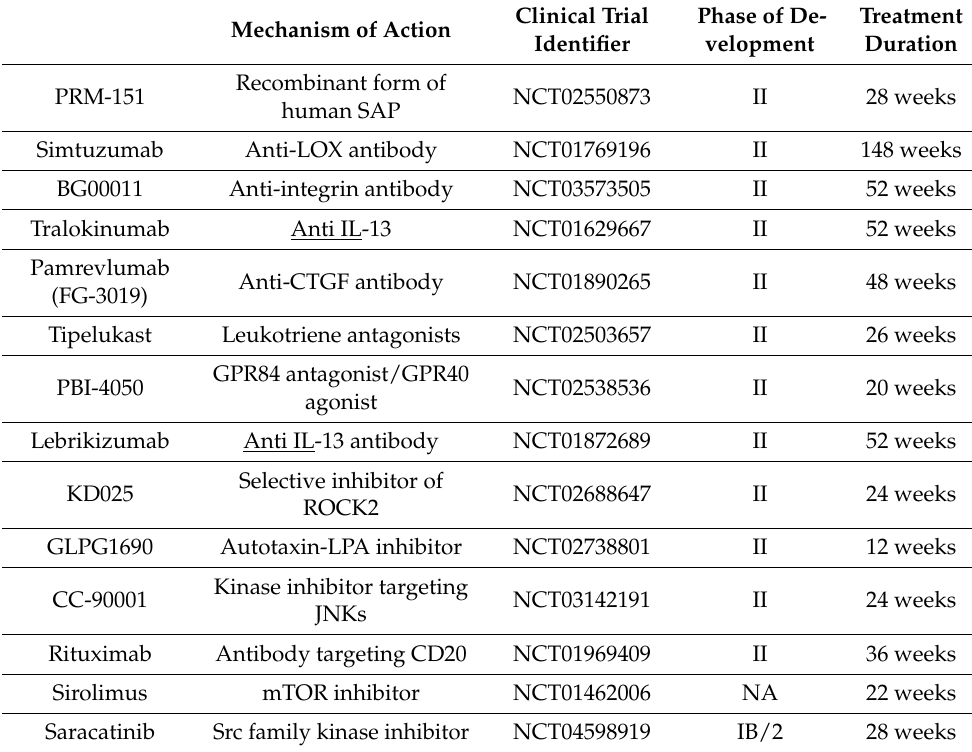
Table 2. Current phase II–III trials in idiopathic pulmonary fibrosis